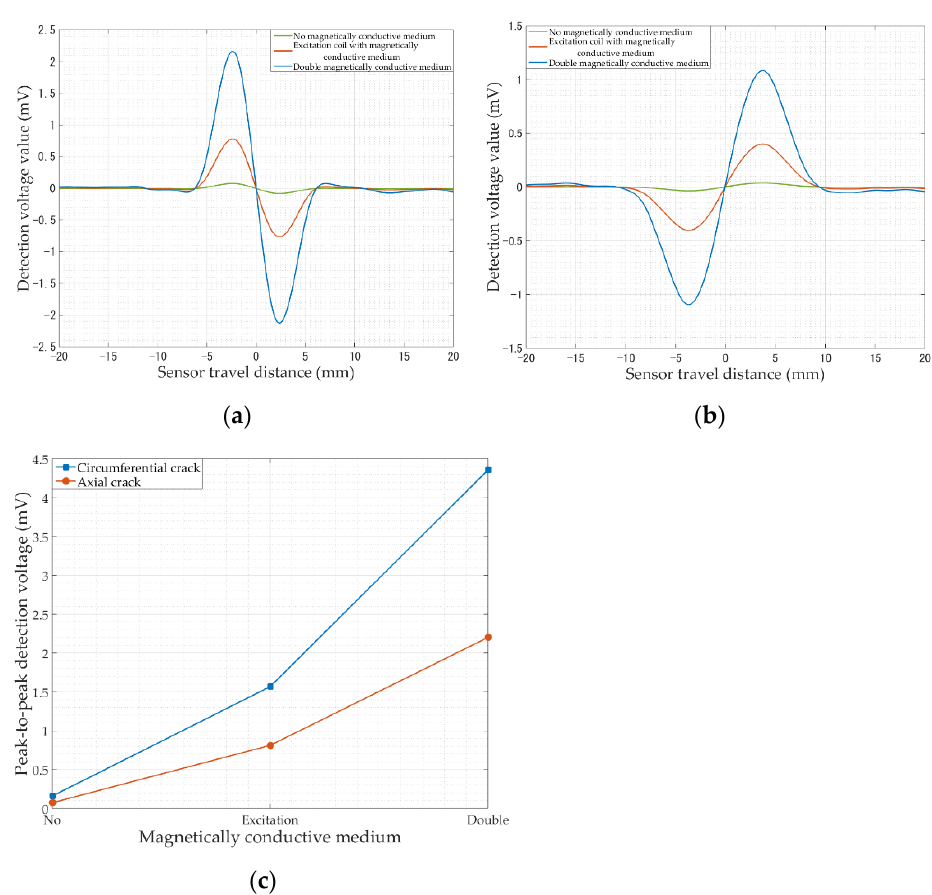
Figure 5. ( a ) Simulation voltage signal of circumferential crack; ( b ) simulation voltage signal of axial crack; ( c ) comparison of signal amplitude of detection voltage.